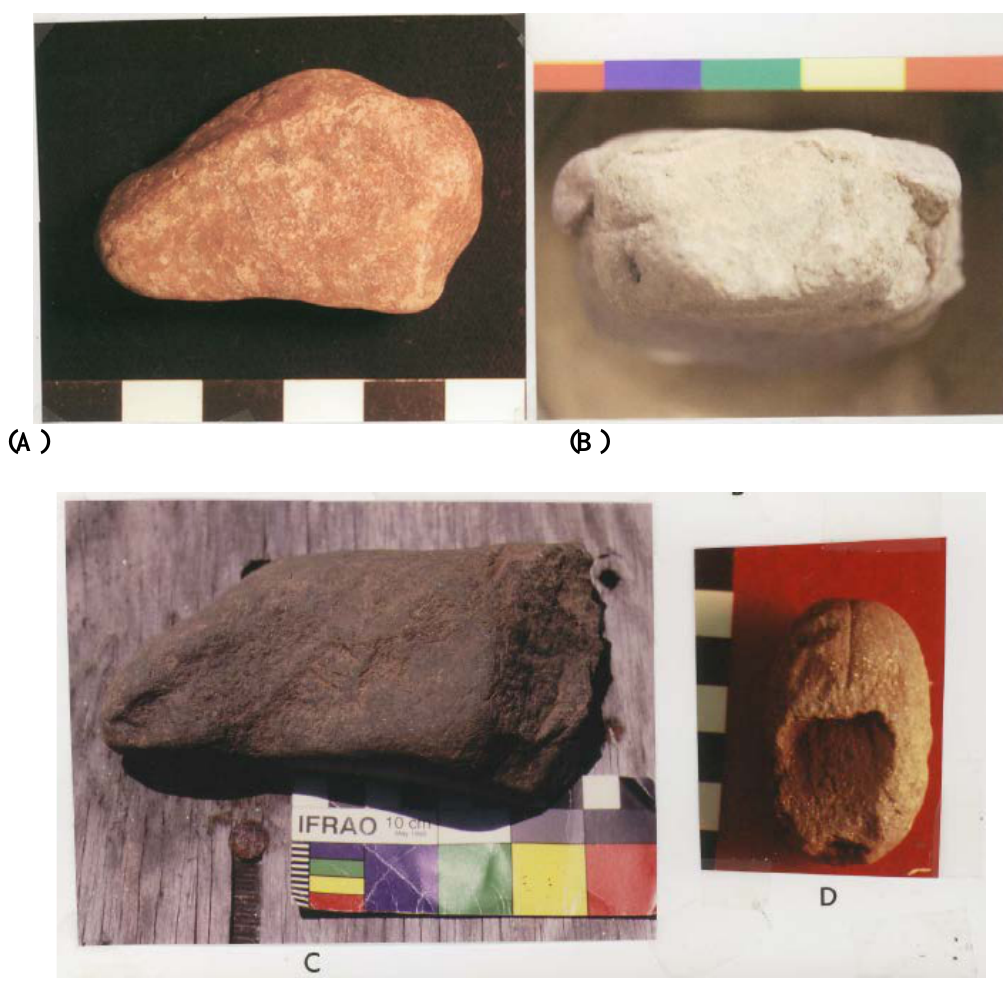
Figure 11. Examples of “expedient imagery”. ( A ) a small pebble resembling a bison; ( B ) an erratic resembling a frog and covered with red pigment; ( C ) an erratic resembling a bird or reptile. This specimen had been longitudinally cloven, possibly to enhance stability upon placement; ( D ) a possible phallic representation; ( E ) possible Zoomorph. Photos by